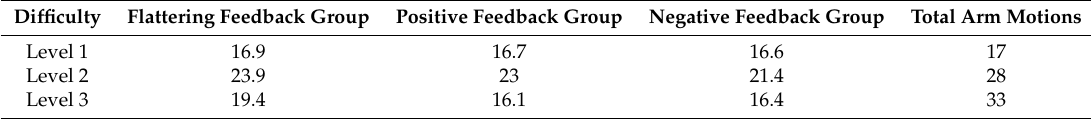
Table 5. Average performance for each difficulty